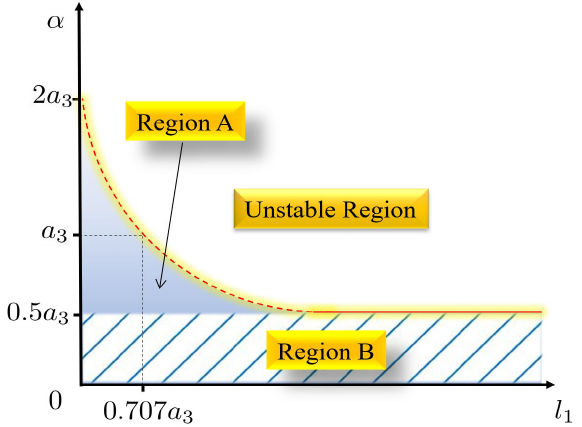
Figure 10. Relatively desirable performance region of ROPIO compensated